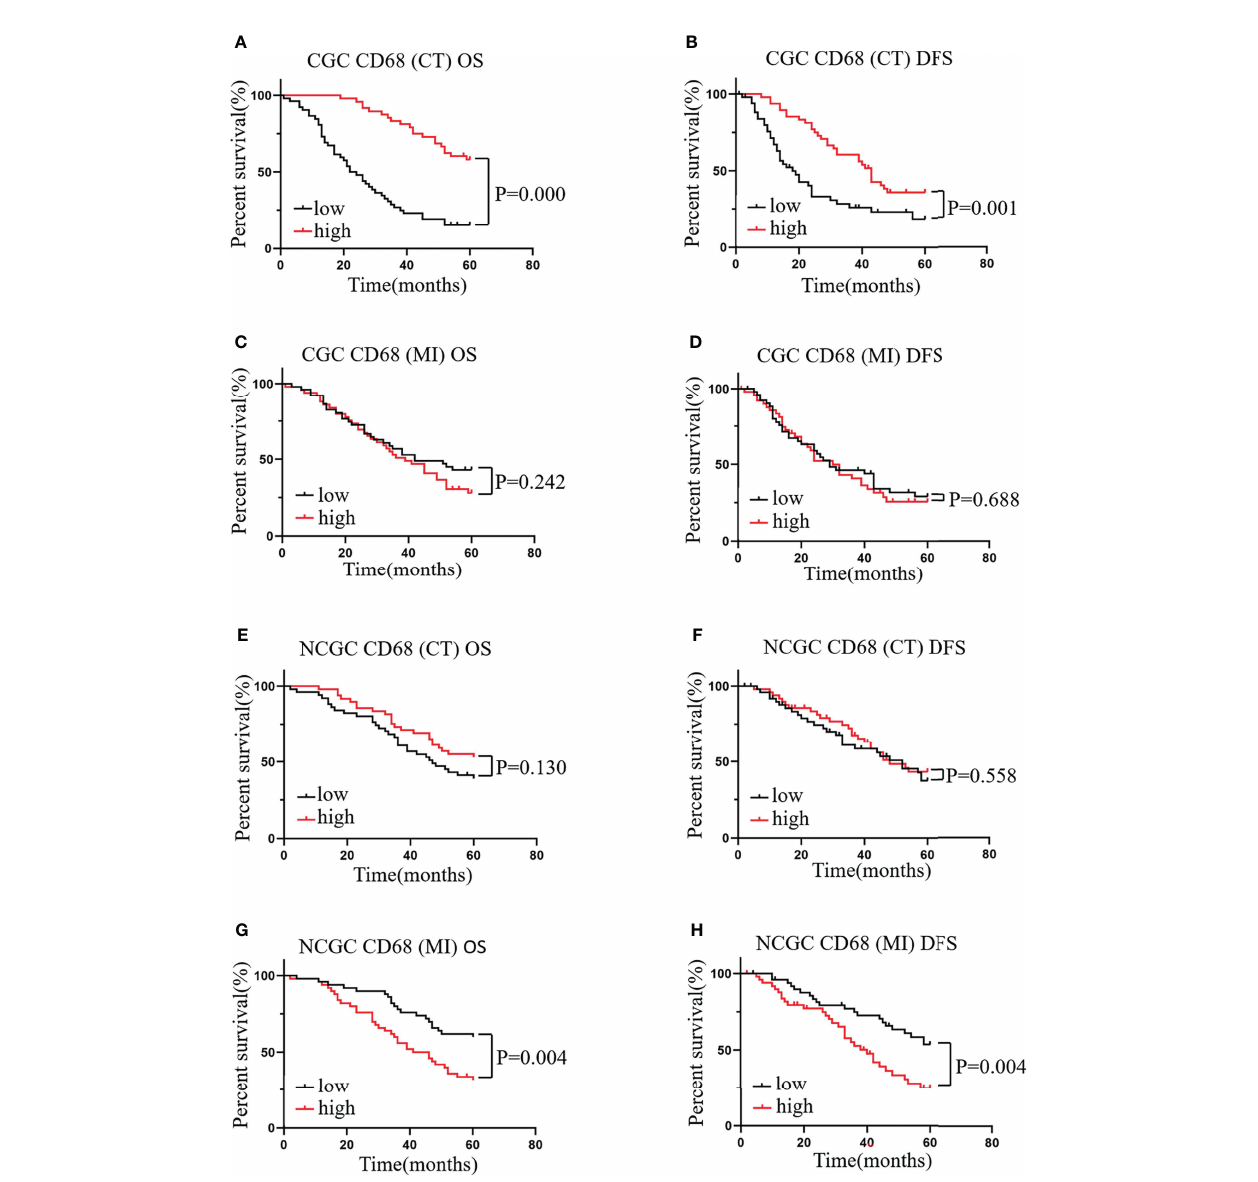
FIGURE 2 | The relationship between CD68 + macrophages in different locations and prognosis and clinicopathological features of patients with CGC and NCGC. (A, B) A higher number of CD68 + macrophages at the CT was associated with better OS and DFS in CGC. (C, D) . A higher number of CD68 + macrophages at MI not correlated with OS or DFS in CGC. (E, F) A higher number of CD68 + macrophages at the CT was not correlated with OS or DFS in NCGC. (G, H) A higher number of CD68 + macrophages at the MI was closely correlated with poor OS and DFS in NCGC. CT, core of primary tumors; MI, invasive margin of primary